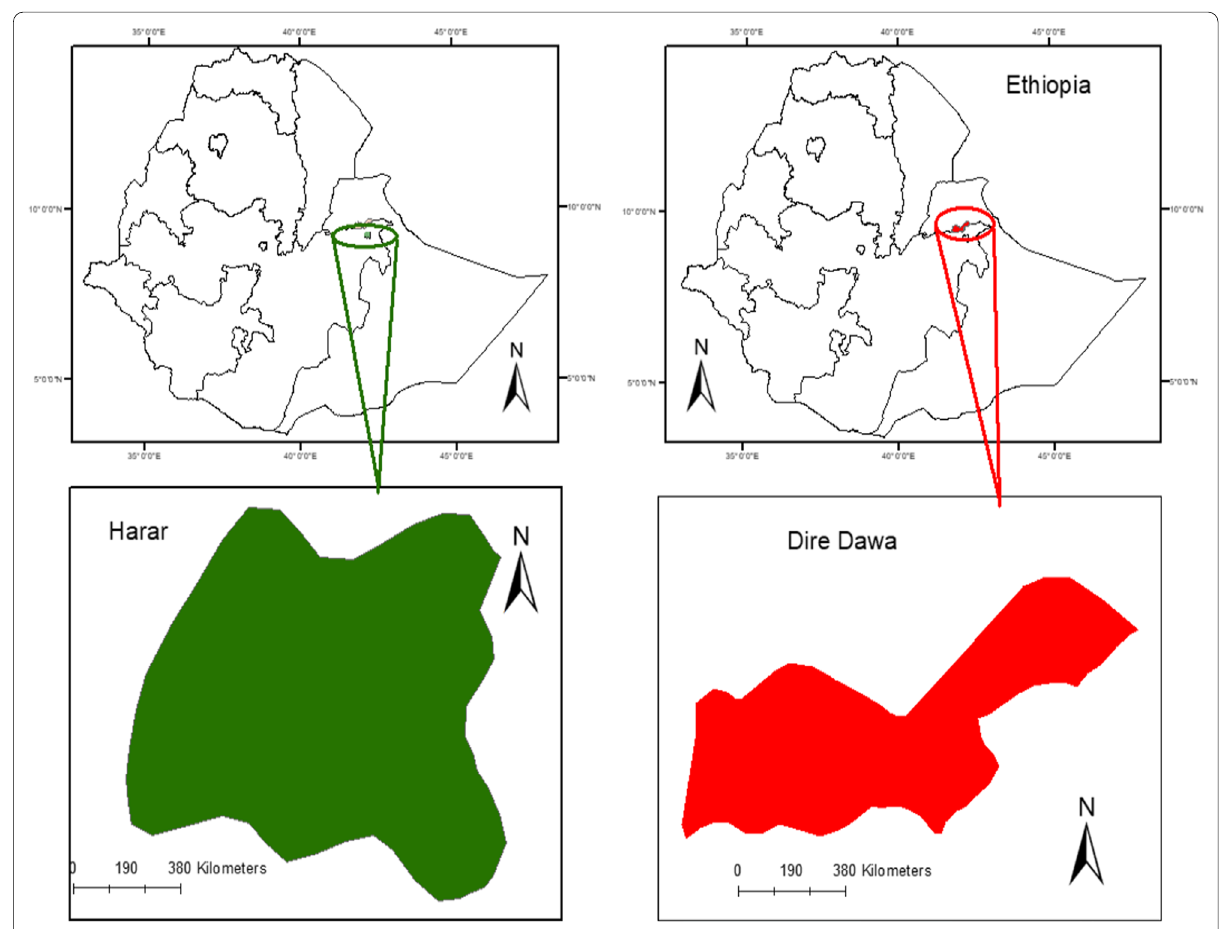
Fig. 1 Map of study area depicting Harar region and Dire Dawa city